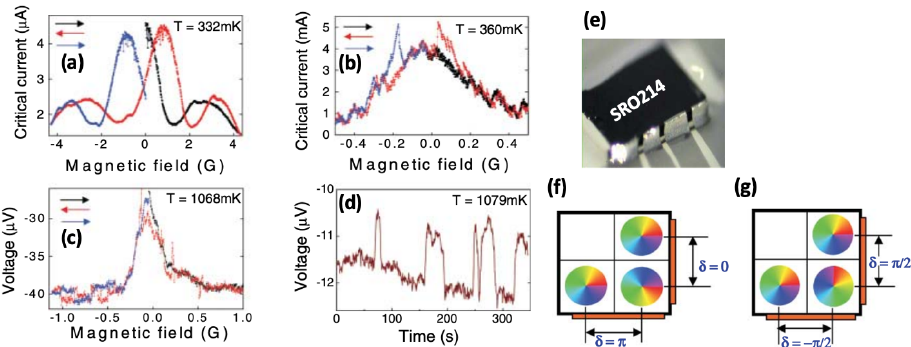
Figure 6. I c ( H ) of Pb/SRO214 junctions with a pure single crystal SRO214. ( a ) At low temperatures (332 mK), I c ( H ) shows a hysteresis and ( b ) sharp I c transitions. ( c ) Close to T c , the hysteretic behaviour is decreased while switching of I c is still observed. ( d ) Telegraphic-like noise in the voltage at fixed bias currents above I c at zero applied magnetic field. ( e ) A scanning electron micrograph of the junction. ( f , g ) Configurations of chiral domains utilised for simulations; explained in the text. (Adopted with permission from [31] copyright AAAS